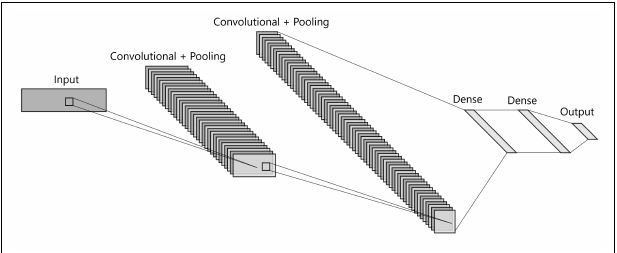
Figure 9. Illustration of the machine learning model with a matrix as input and 5